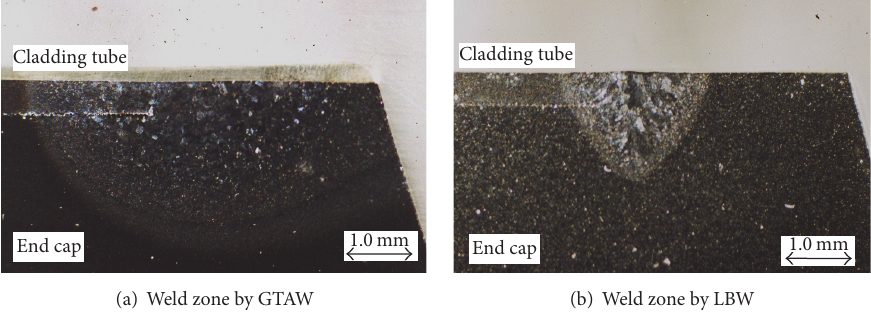
Figure 2: Microstructures of weld zone in fusion welding.